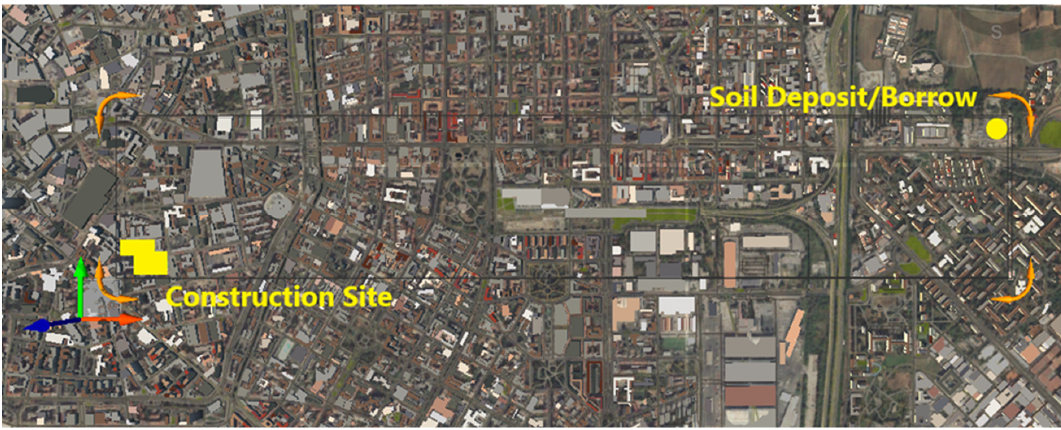
Figure 7. The locations of the hospital construction site and the soil deposit/borrow in a broader context (Autodesk